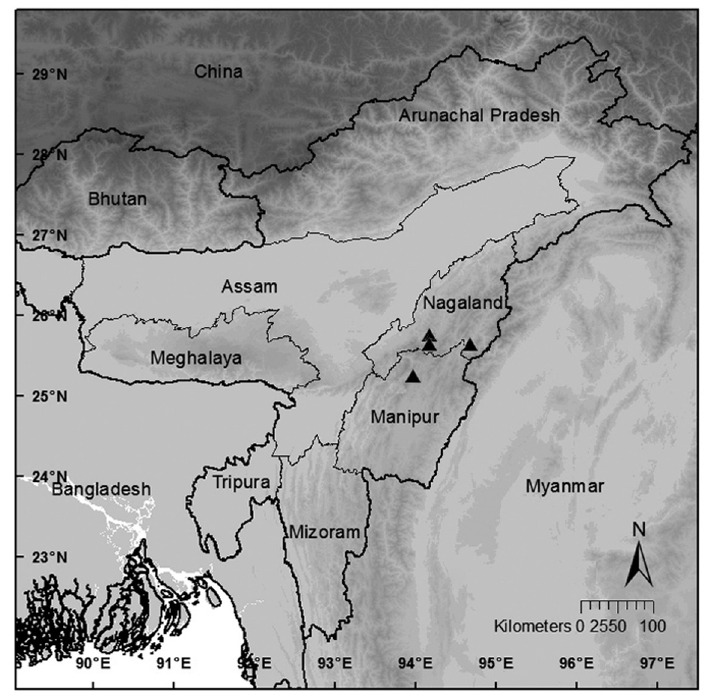
Fig. 33. Map showing the location of B. koelzii R.Camfield sp. nov.